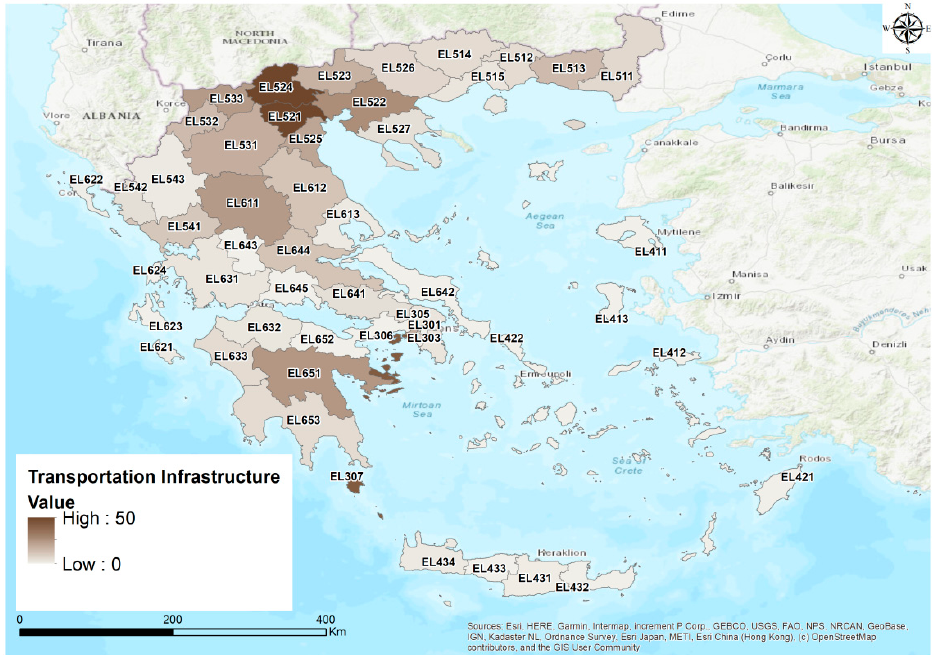
Figure 8. Spatial distribution of the ratio of transportation infrastructure in flood zones per NUTS 3.